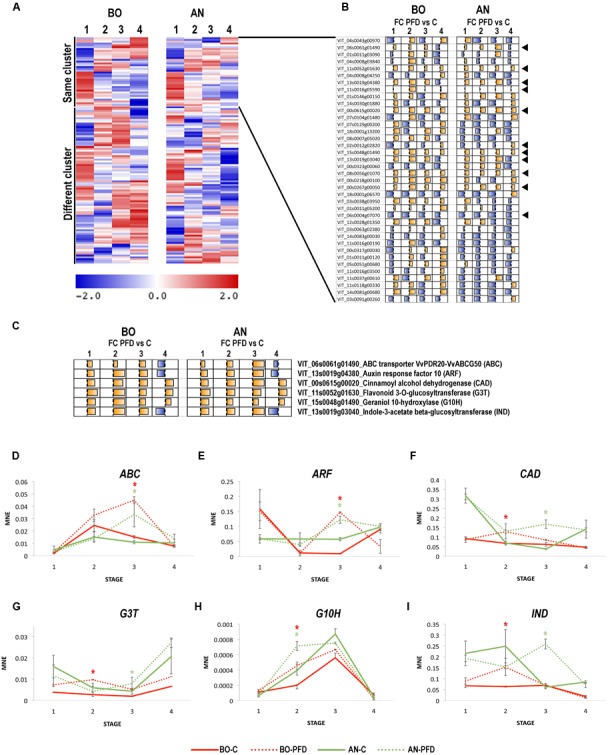
PFD treatment molecular markers of Sangiovese cultivar selection and real-time qPCR validation in 2012. (A) Heat map representing the fluorescence intensity of C vines in the 125 commonly modulated genes. KMC analysis was used to determine the transcripts with unaltered expression between Bologna and Ancona sites (highlighted as same cluster) and those with different expression (highlighted as different cluster). (B) Schematic representation of the Fold Change (FC), calculated between C and PFD vines at each developmental stage in Ancona and Bologna, in the 38 same cluster transcripts found in (A). The black arrows indicate the 11 genes showing a similar trend of FC. (C) FC between C and PFD vines at each developmental stage in Ancona and Bologna in a selection of six transcripts. (D–I) Real-time qPCR validation of the (D) ABC transporter VvPDR20-VvABCG50 (ABC; VIT_06s0061g01490), (E) Auxin response factor 10 (ARF; VIT_13s0019g04380), (F) Cinnamoyl alcohol dehydrogenase (CAD; VIT_00s0615g00020), (G) Flavonoid 3-O-glucosyltransferase (G3T; VIT_11s0052g01630), (H) Geraniol 10-hydroxylase (G10H; VIT_15s0048g01490) and (I) Indole-3-acetate beta-glucosyltransferase (IND; VIT_13s0019g03040) expression profiles in PDF and C Sangiovese vines during berry development in 2012. The mean normalized expression (MNE)-value was calculated for each sample referred to the VvUBIQUITIN1 (VIT_16s0098g01190) expression according to the Simon equation (Simon, 2003). Bars represent means ± SE of three biological replicates. The significant modulation (t-test, p < 0.05) of gene expression between C and PFD berries at each stage per each site is indicated by an asterisk, red for BO and green for AN.